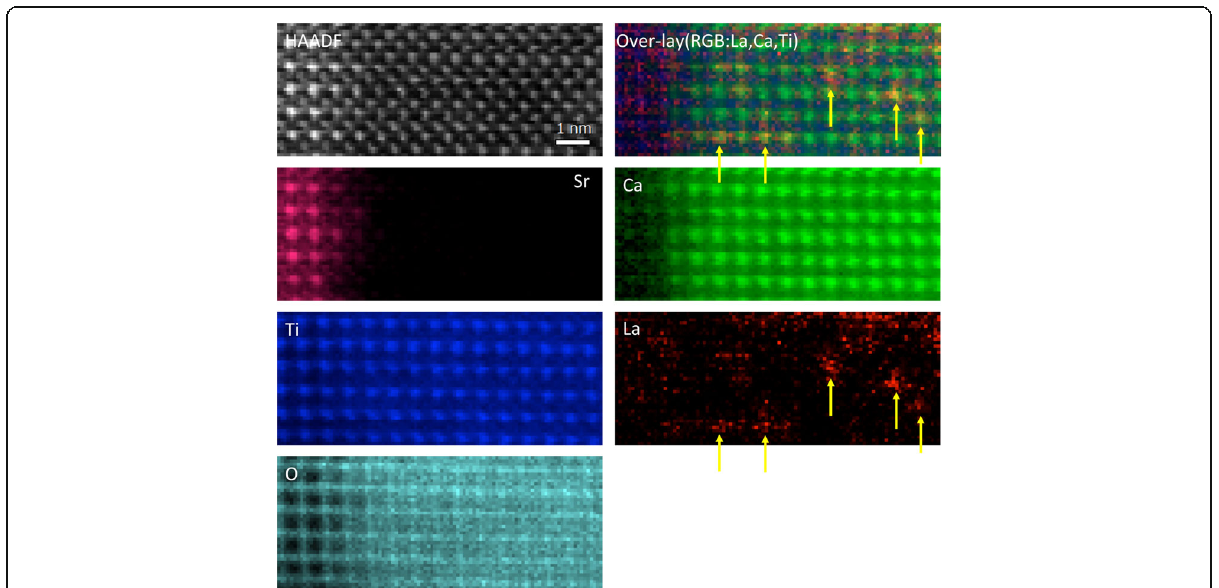
Fig. 11 HAADF image of La-doped CaTiO 3 grown on a SrTiO 3 substrate with EELS images resolving the Ca, Ti, and O columns, and also revealing individual La atoms. The composite color image shows single La atoms in their respective columns. Data obtained with a Gatan Quantum ER on